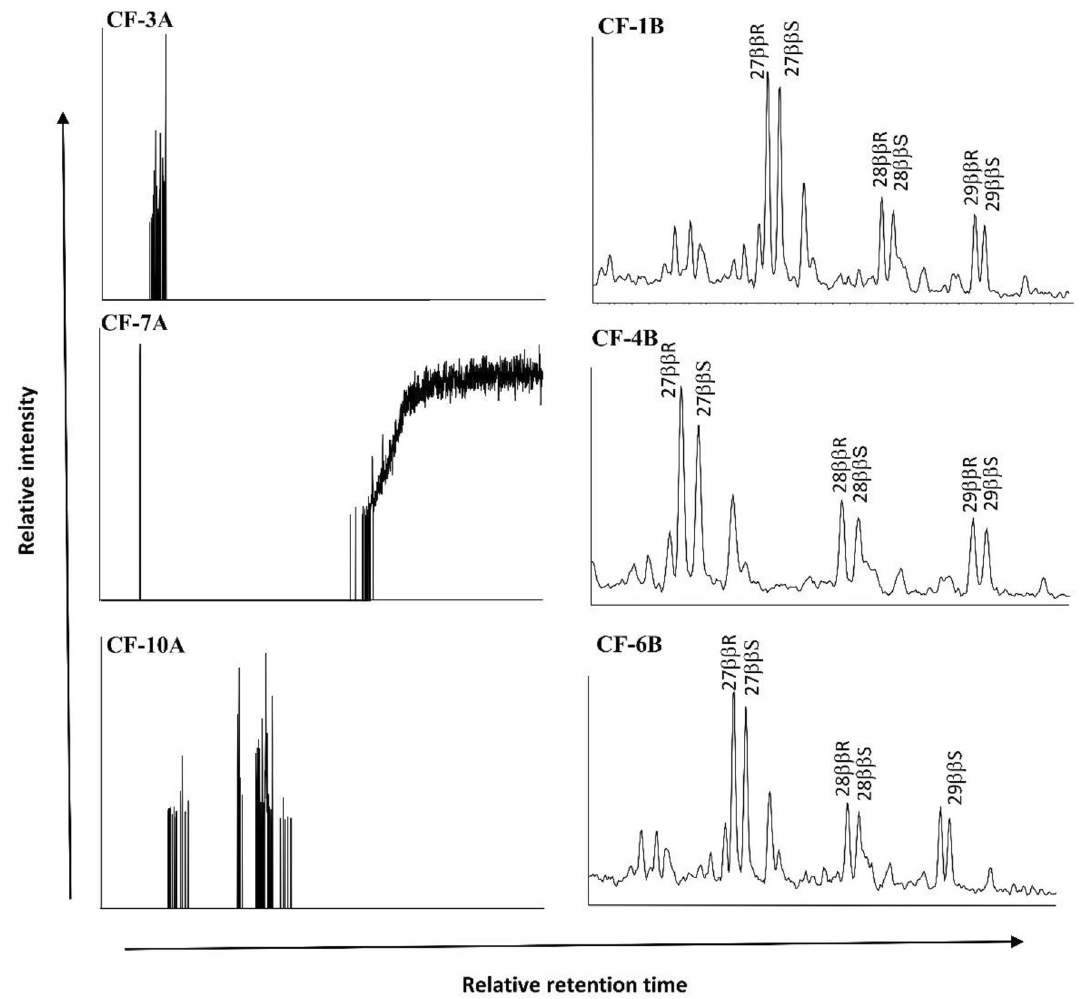
Fig. 10 m/z 218 chromatograms of Mela-05 drill cuttings (left) and outcrop samples (right) showing distribution of steranes